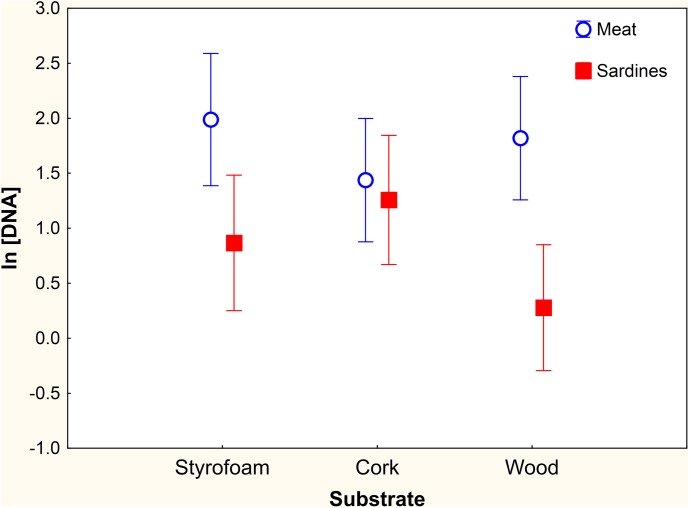
Log-transformed DNA concentration (ng μl-1) in saliva extracts.Means and 95% CI are shown for every combination of substrate and bait, once records >60 ng μl-1 were excluded.